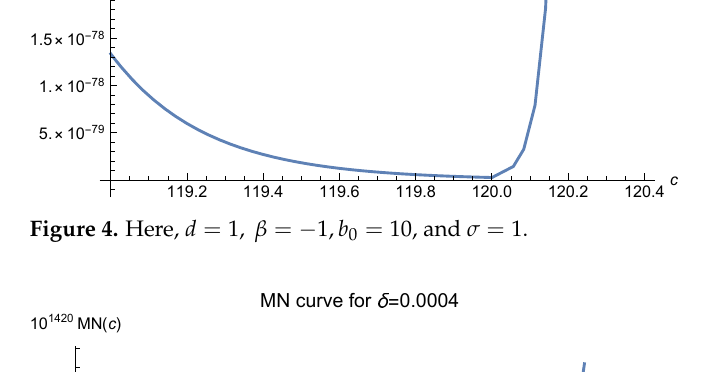
MN curve for = 0.0004 (cid:1)